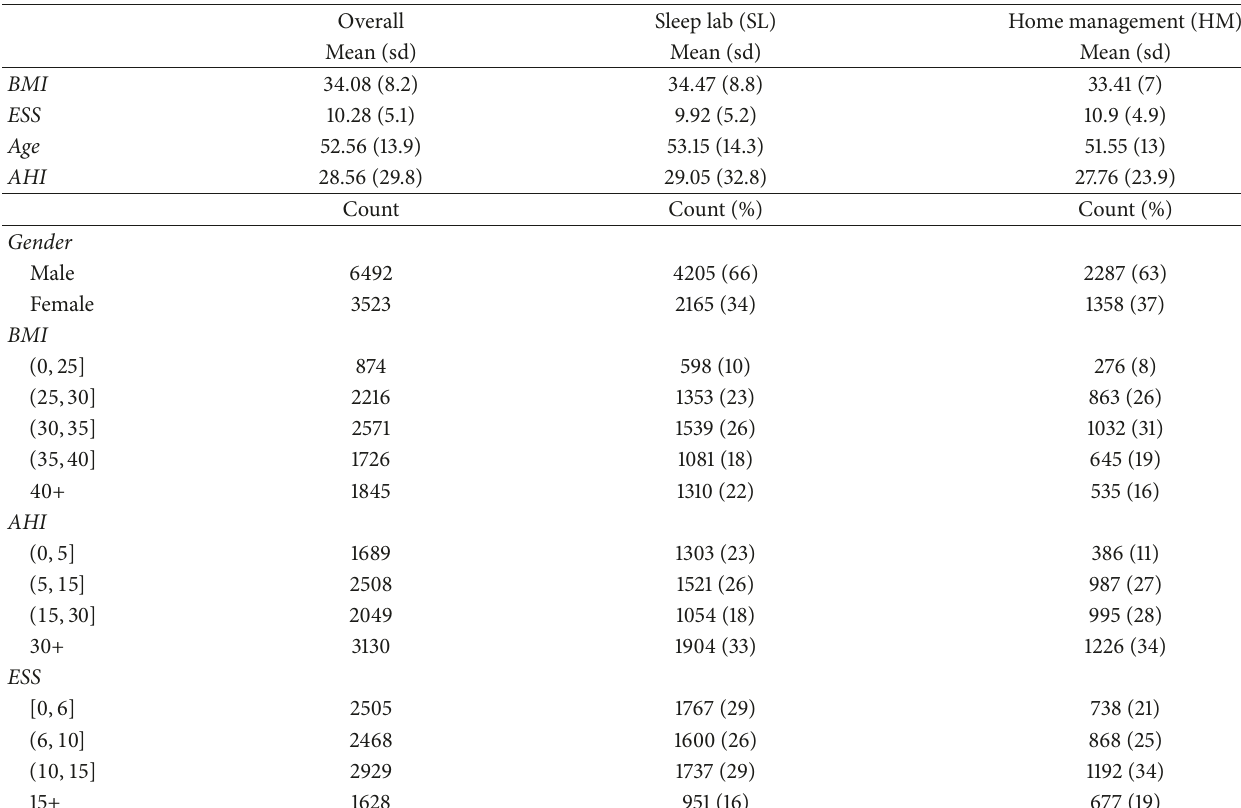
Table 2: Patient demographics (overall and by diagnostic pathway). Continuous variables are presented as mean (sd), with categorical variables presented as counts and